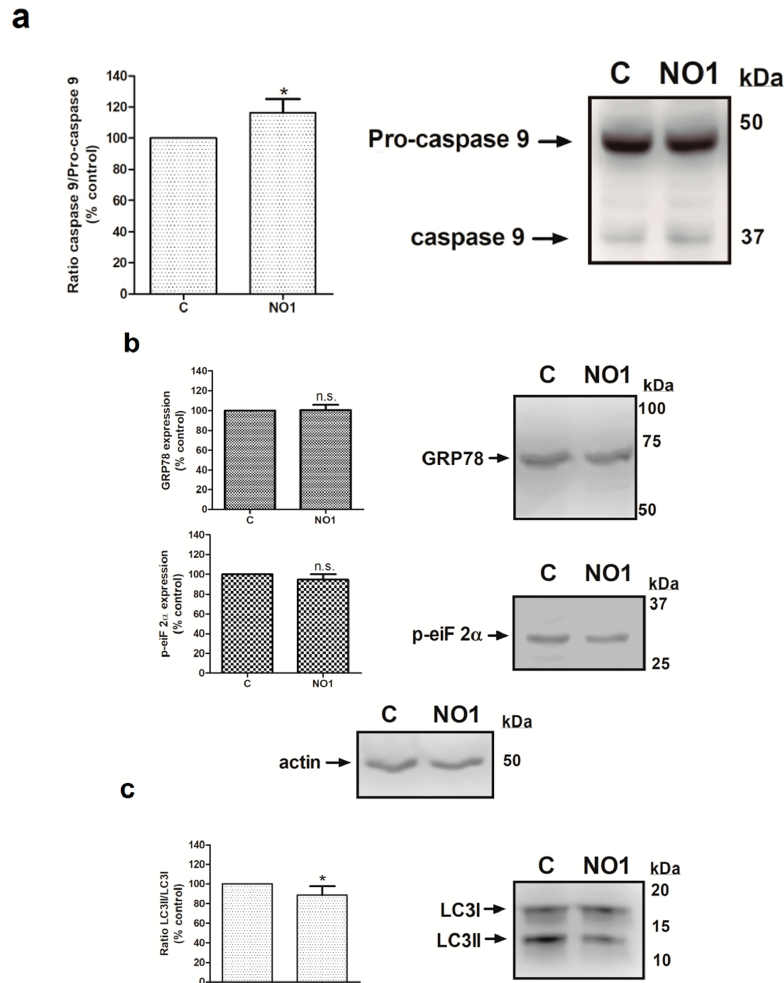
Figure 5. NO1 promotes the activation of caspase 9. MDA-MB-231 cells were stimulated with NO1 (100 nM) for 5 min, or were left untreated. Then, they were mixed with LB. Subsequently, Western blotting of the sample lysates was done using the anticaspase 9 ( a ), antiphosphor-eiF2 α ( b ), anti-GRP78 ( b ), and anti-LC3 antibodies ( c ), as described in the Material and Methods section. Membranes were reprobed with actin-antibody as a loading control. Images are representative of four independent experiments, and histograms represent the average of the percentage ± standard error of the mean (S.E.M.) of cells treated with the σ 2R agonist compared to nontreated control cells. * represents p < 0.05 compared to control cells, while n.s. represents p > 0.05.